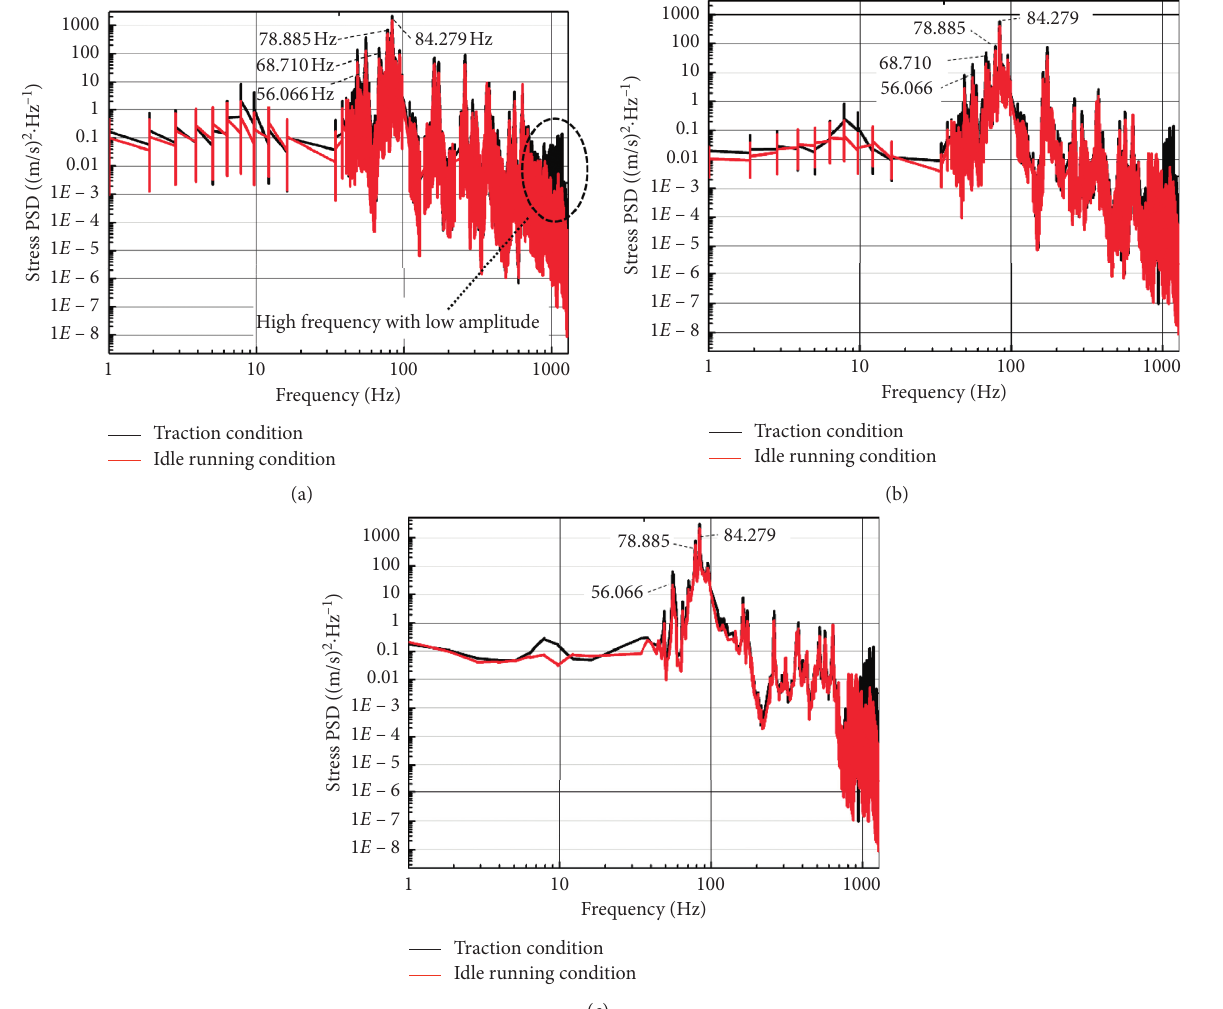
Figure 11: (a) PSD of P1 dynamic stress response. (b) PSD of P2 dynamic stress response. (c) PSD of P3 dynamic stress response. Table 2: The peak and frequency of the dynamic stress response at the key nodes.